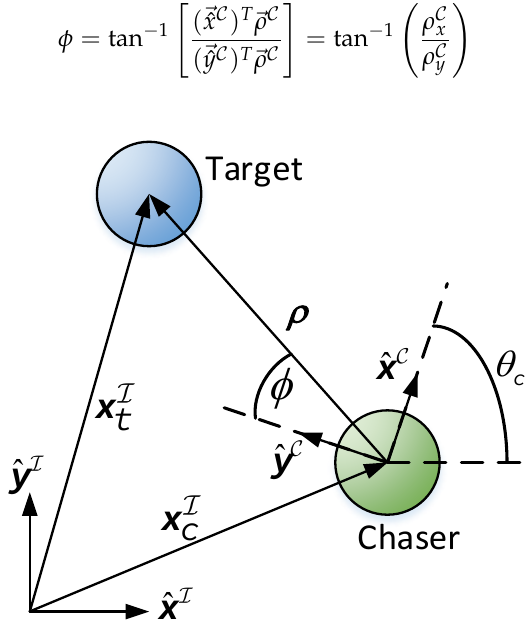
Figure 6. Top view of a chaser and a target, showing the azimuth angle.